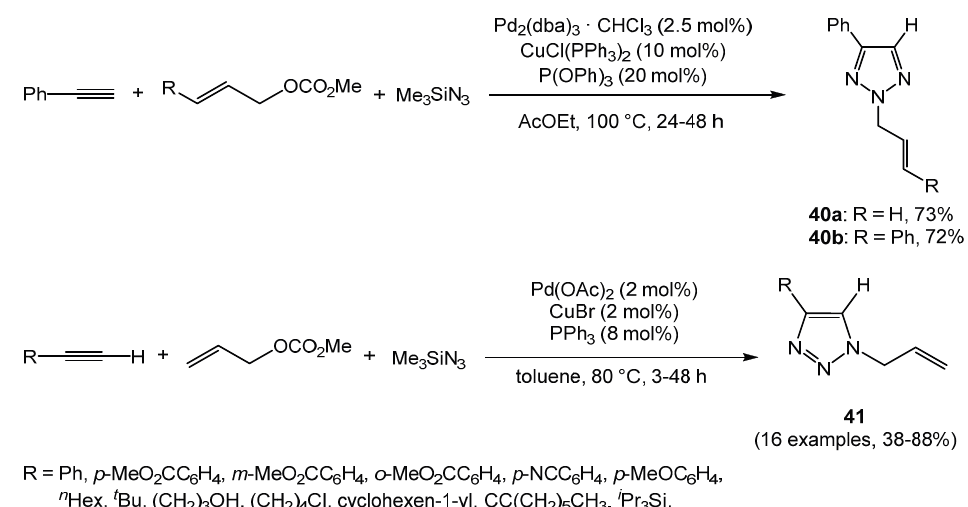
Scheme 26. Pd-catalyzed three-component reaction of alkynes, allyl carbonate, and trimethylsilyl azide to regiospecifically give 2-allyl-1,2,3-triazole 39 .